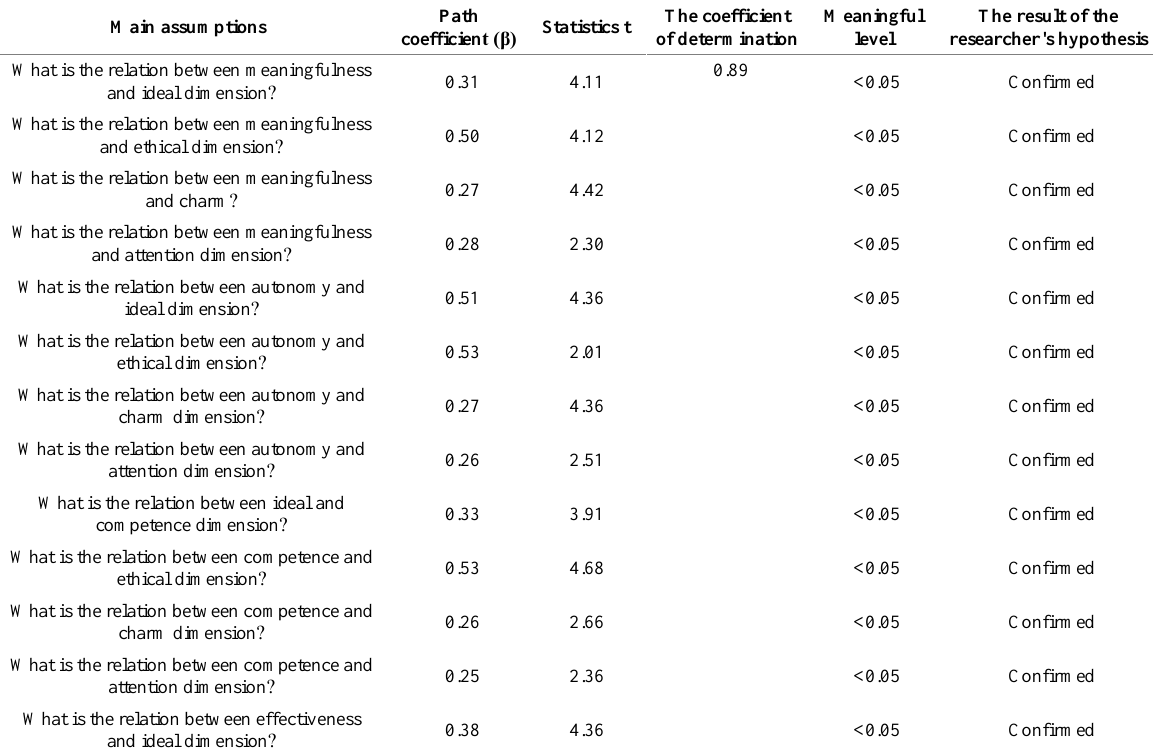
Table 2. Ratio coefficient, t statistic and result of research's